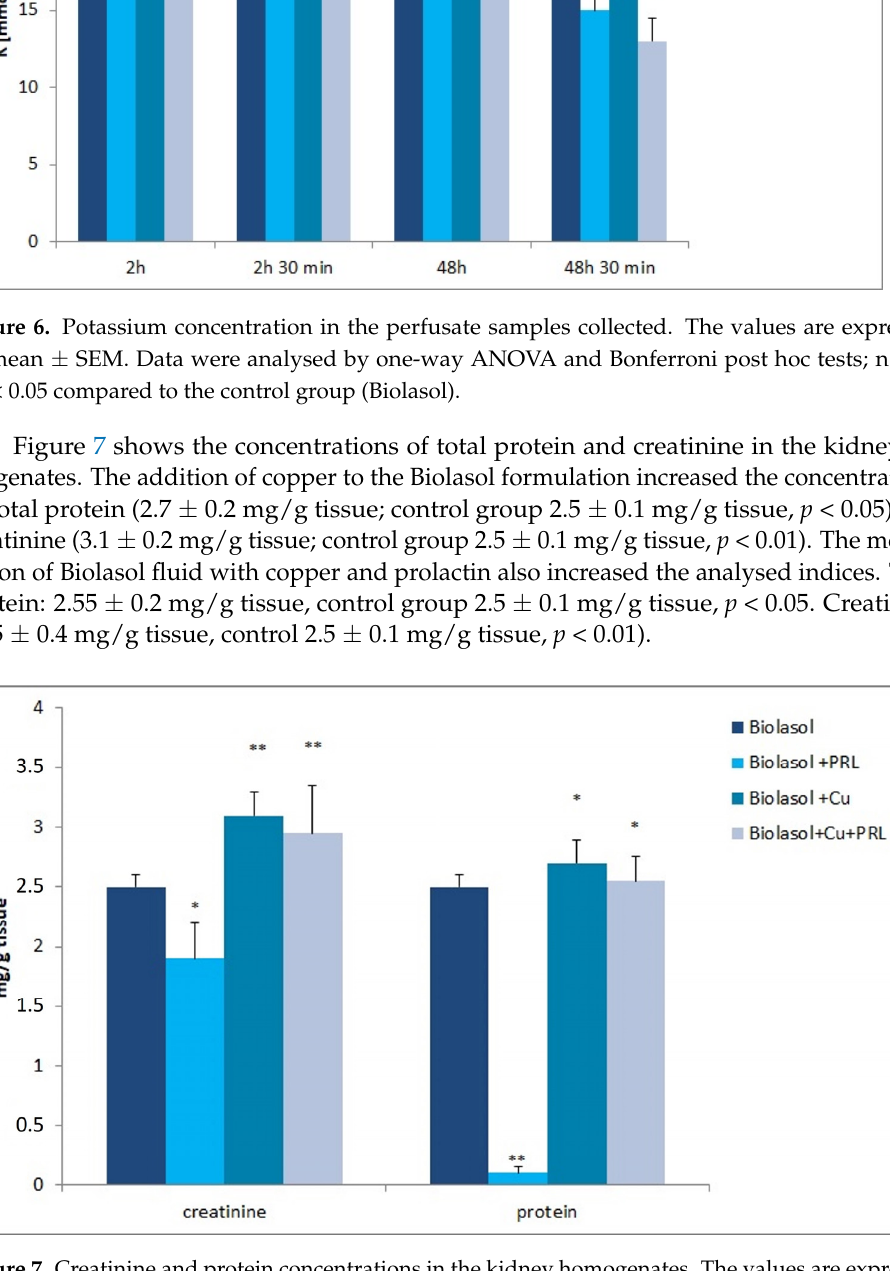
Figure 7. Creatinine and protein concentrations in the kidney homogenates. The values are ex- pressed as mean ± SEM. Data were analysed by one-way ANOVA and Bonferroni post hoc tests; n = 10; * p < 0.05; ** p < 0.01 compared to the control group (Biolasol).